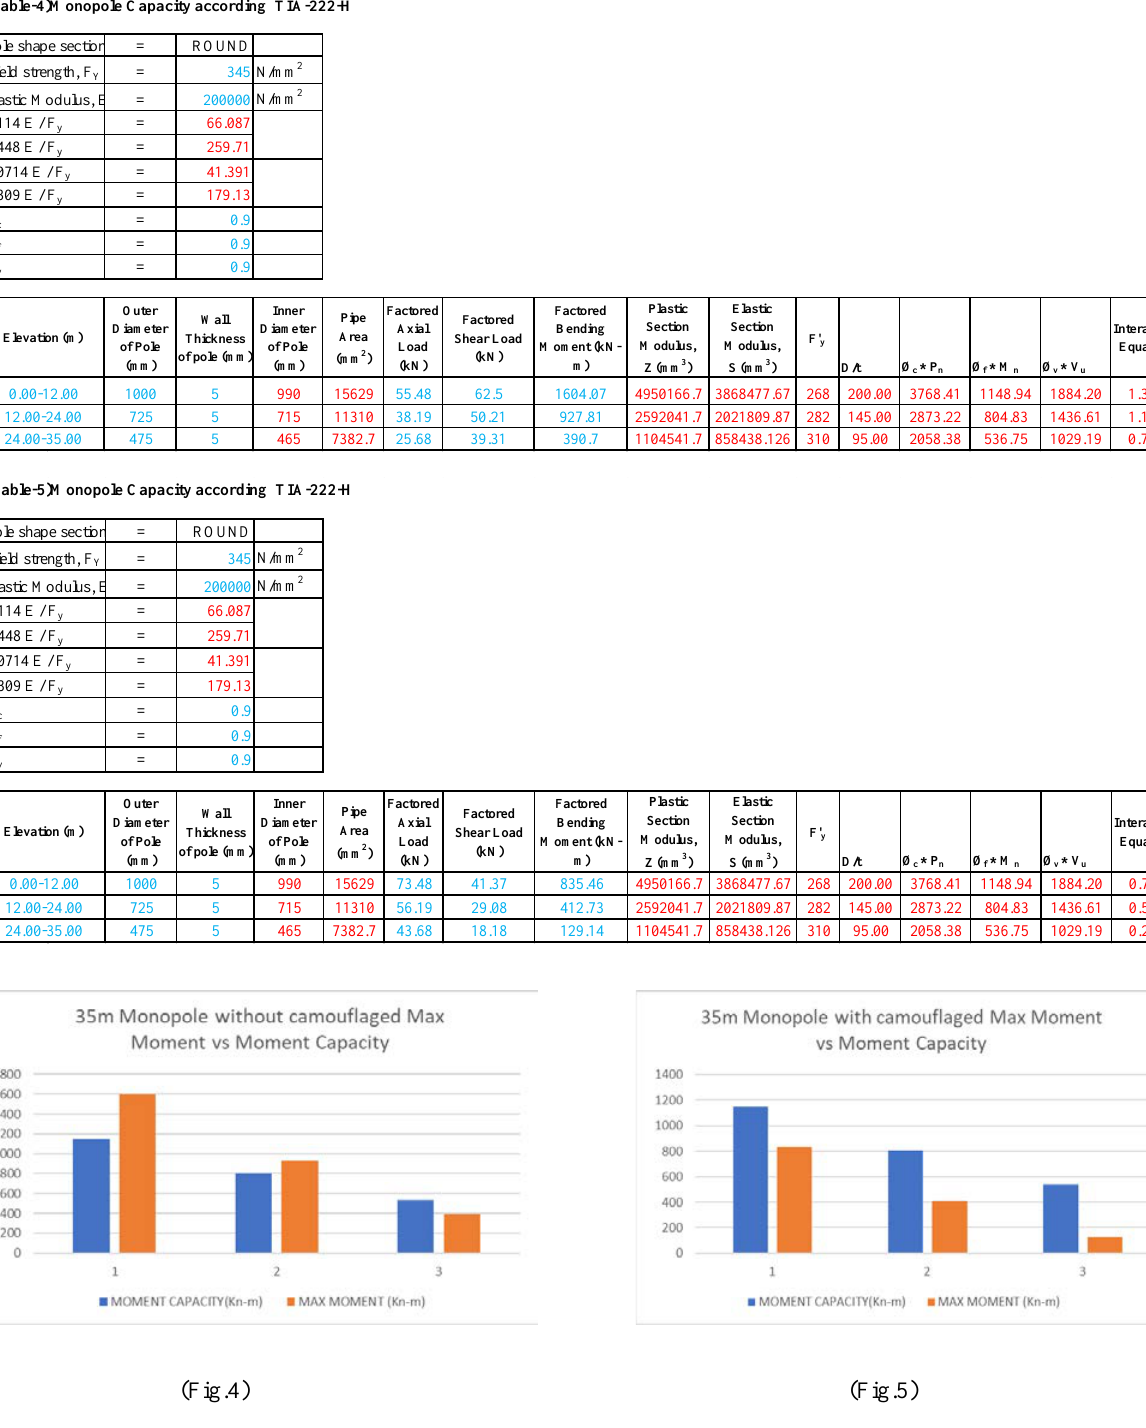
Table 4 (fig.4) and Table 5 (fig.5) Structural steel Pole Moment capacity Vs Max Pole bending Moment for Monopole without camouflaged tower and with camouflaged (Height = 35m and basic wind speed = 44.44m/sec) From Table 4 (fig.4) it was observed that for a 35m tower height monopole without camouflaged with 44.44m/sec basic wind speed, structural steel Max Monopole Moment is more than Pole Moment